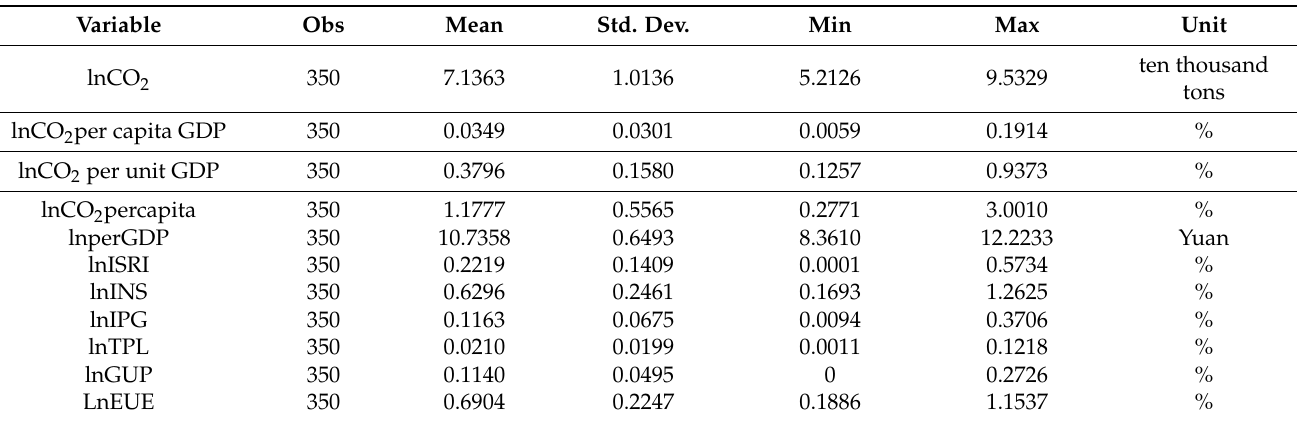
Table 3. Descriptive statistics of all